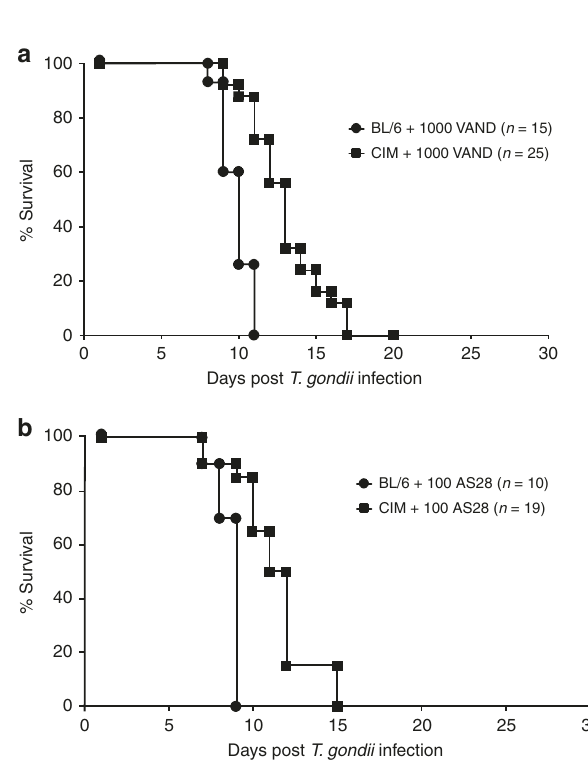
Fig. 4 Irgb2-b1 BL/6 directly binds ROP5C. a Protein-fragment complementation assay. Proteins were fused to N-terminal (BlaN) or C-terminal (BlaC) fragments of TEM - 1 β -lactamase. One-way analysis of variance (ANOVA) followed by Tukey's multiple comparison was used to test differences between groups; **** p < 0.0001; n.s. not signi fi cant. The kinetic of the reaction is shown for one representative experiment (left hand panel). Irgb2-b1 BL/6 interacts with T. gondii ROP5C but not ROP5B and ROP5A. b Yeast two-hybrid. Proteins were expressed as fusion with transcriptional activation domain (AD) from pGAD-C3 or DNA-binding domain (BD) from pGBD-C3. Colony growth is indicative of Irgb2-b1 BL/6 and Irgb2-b1 Chimera interaction with ROP5C and Irgb2-b1 CIM interaction with ROP5B. Bold black lines separate samples from negative controls. c Intensities of individual vacuoles detected by immuno fl uorescence with anti-Irgb2-b1-speci fi c antiserum in interferon- γ (IFN γ )-induced (200 U ml − 1 ) cells infected for 2 h with RH Δ hxgprt . Kruskal – Wallis test followed by Dunn's multiple comparisons was used to test differences between groups; **** p < 0.0001; n.s. not signi fi cant. Intensities of Irgb2-b1 BL/6 and Irgb2-b1 Chimera are reduced at RH Δ hxgprt -derived vacuoles. d Polymorphic Irgb2-b1 CIM interface mediating ROP5B binding is crucial for T. gondii control in vitro. CIM diaphragm-derived cells (DDCs) were induced with 100 U ml − 1 IFN γ for 24 h and infected with T. gondii RH-YFP at a multiplicity of infection (MOI) of 1 or 3. Parasite growth was determined by fl ow cytometry 24 h post infection. One-way ANOVA followed by Dunnett's multiple comparisons was used to test differences between CIM wild-type (wt) and other cells; **** p < 0.0001; *** p < 0.0008; ** p < 0.006; n.s. not analysis and maximum likelihood tree of Irgb2 sequences (CIM, M. m. castaneus ; CAST, M. m. castaneus ; LAB, M. m. domesticus ; PWK, M. m. musculus ;